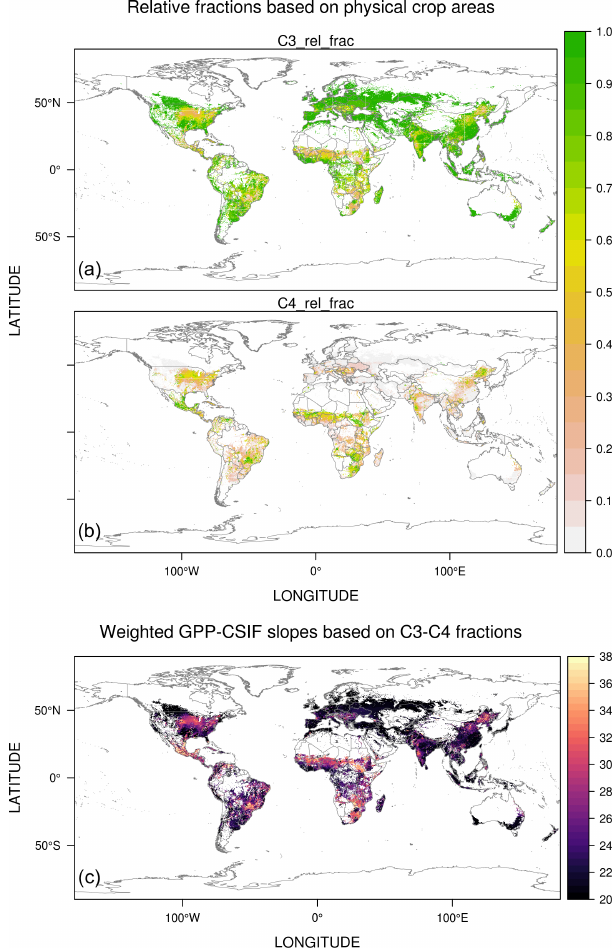
Figure 2. Spatial distribution of the estimated C 3 : C 4 ra- tio [%] (a–b) using physical areas of 42 crop species from MapSPAMv1 and weighted mean GPP–CSIF slopes